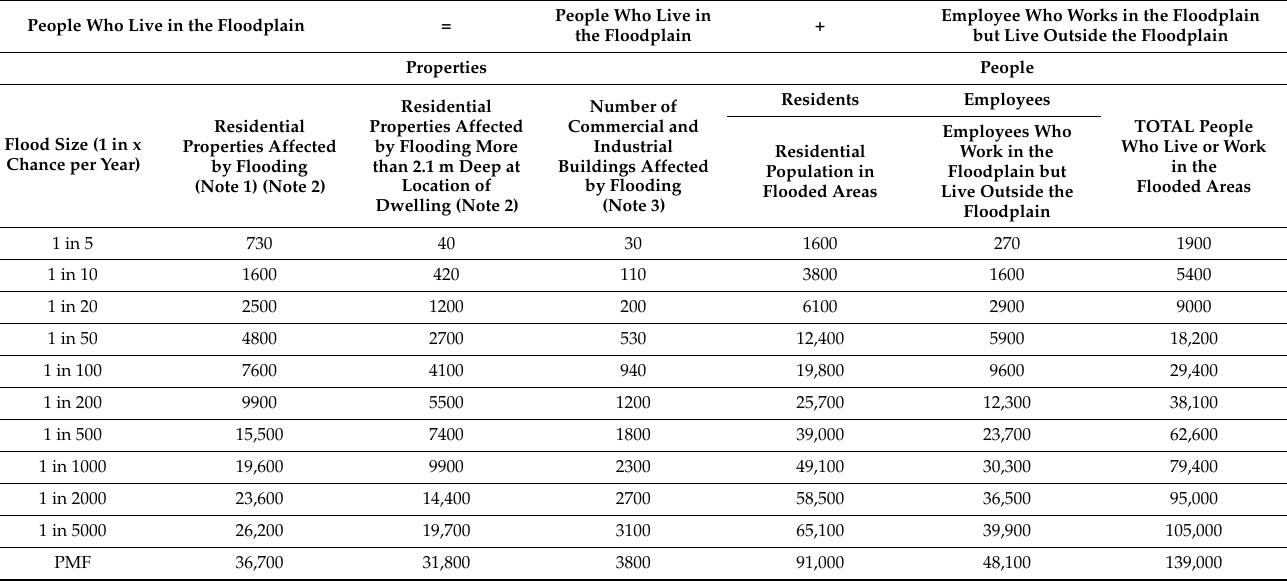
Table 1. Estimated number of properties and people affected by flooding in the Hawkesbury-Nepean Floodplain [Source: HNV Strategy: January